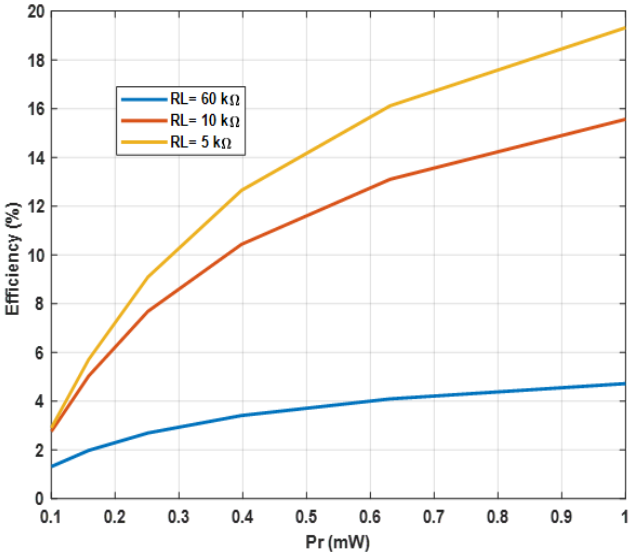
Figure 27. Efficiencies for different R L and P r for the rectifier circuit in Approach